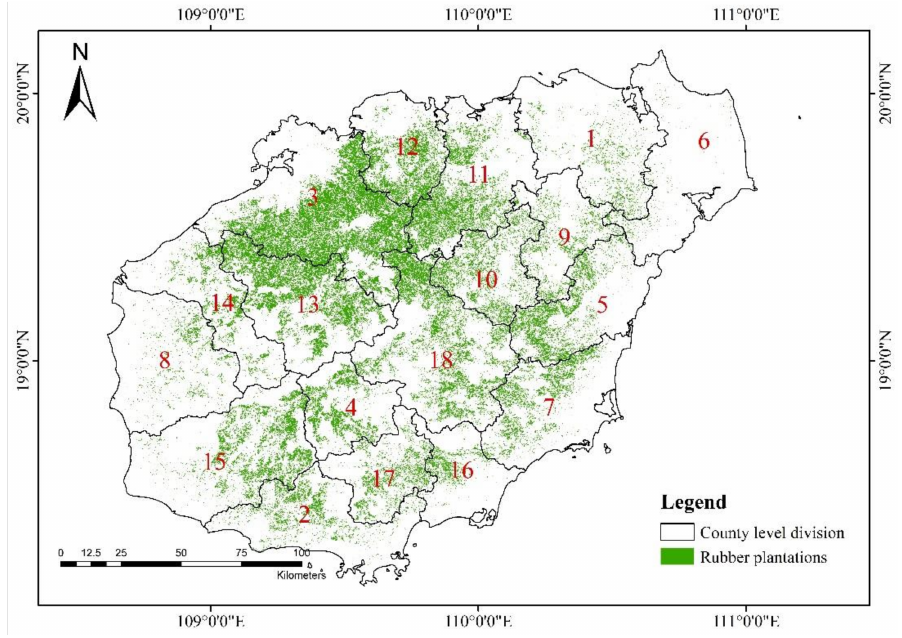
Figure 6. Spatial distribution of rubber plantations in Hainan Province in